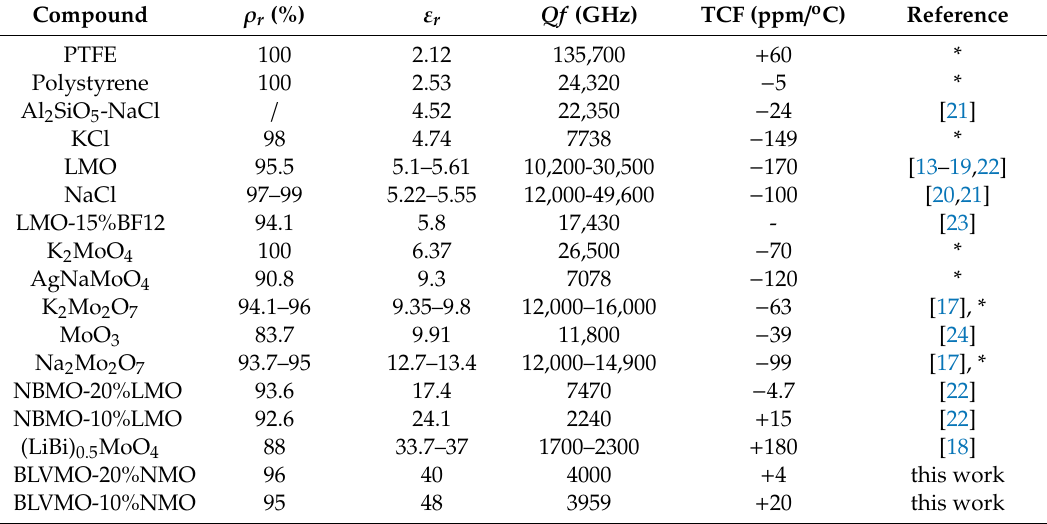
Table 2. Comparison of relative densities, and microwave properties of cold-sintered microwave dielectric materials (* unpublished work, ρ r = relative density, PTFE = Polytetrafluoroethylene, LMO